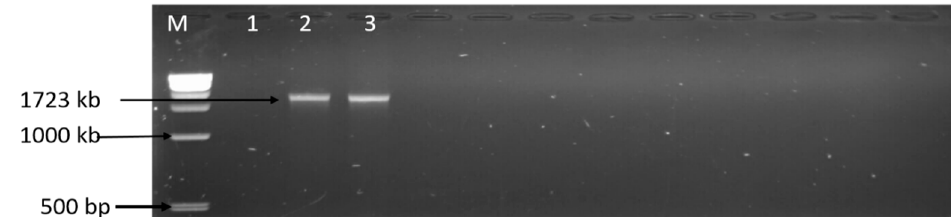
Figure 6. Gel image of the PCR-confirmed flaA gene. Lane M: DNA ladder (1 kb); lane 1: negative control; lanes 2–3: positive Campylobacter isolates that harboured the flaA gene (1723 kb).